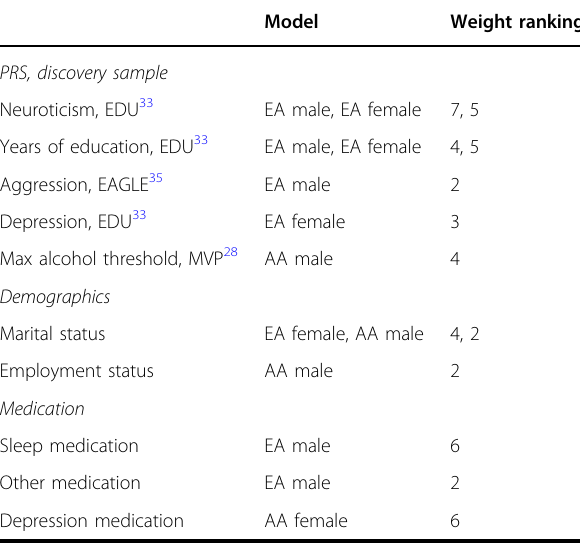
Table 2 Selected discriminative PRS and demographic features predicting AUD remission strati fi ed by ancestry and